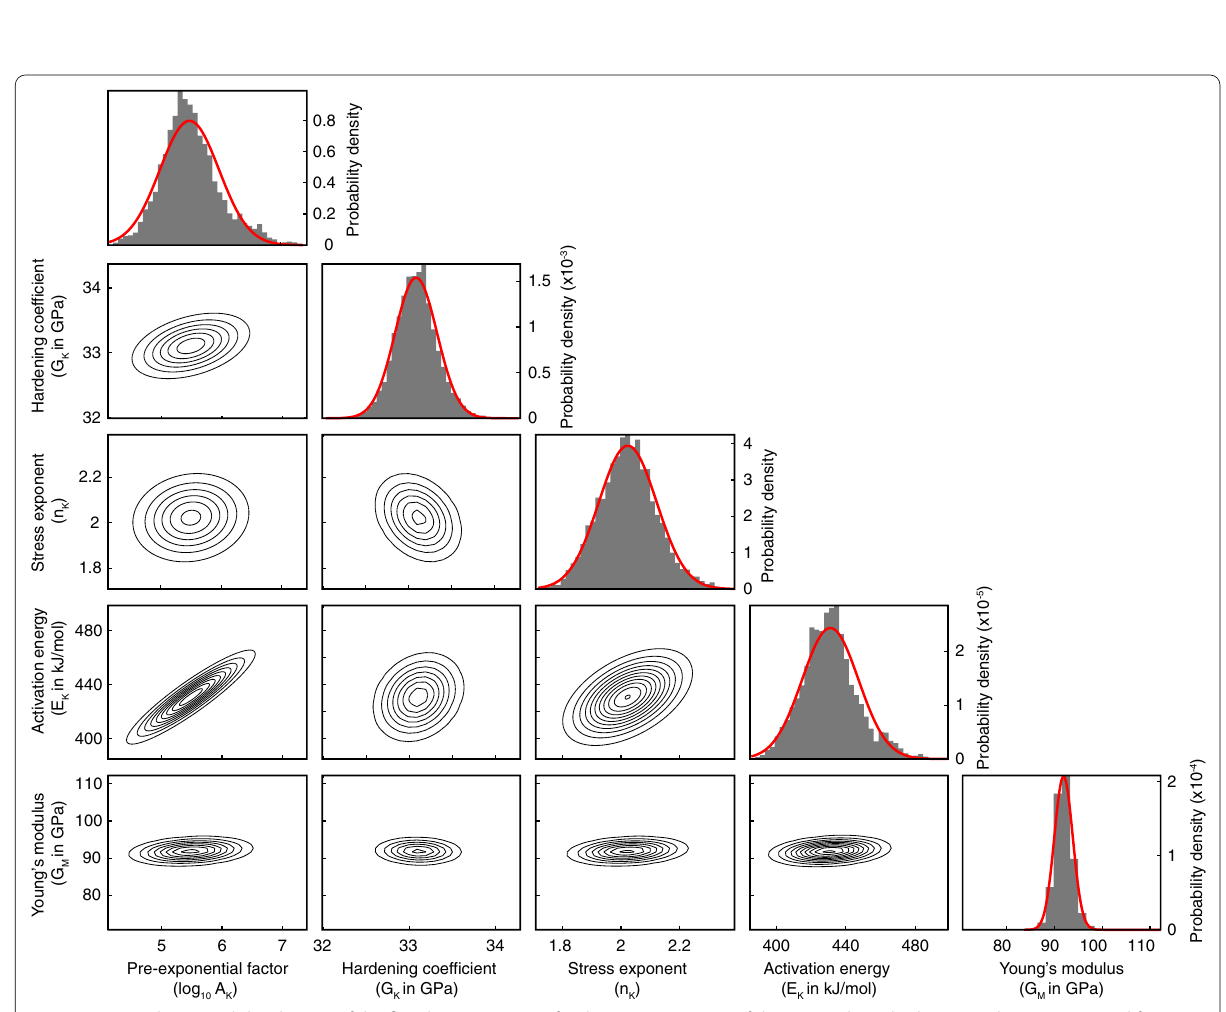
Fig. 3 Joint and marginal distribution of the flow law parameters for the transient creep of dunites under anhydrous conditions generated from Gibbs sampling. We generate 2 × 10 5 samples, discard the initial 10 4 samples and from the remaining samples, we select every 100 th samples to produce the univariate and bi-variate marginal distributions. The probability density of the model parameters approaches that of a multi-variate normal